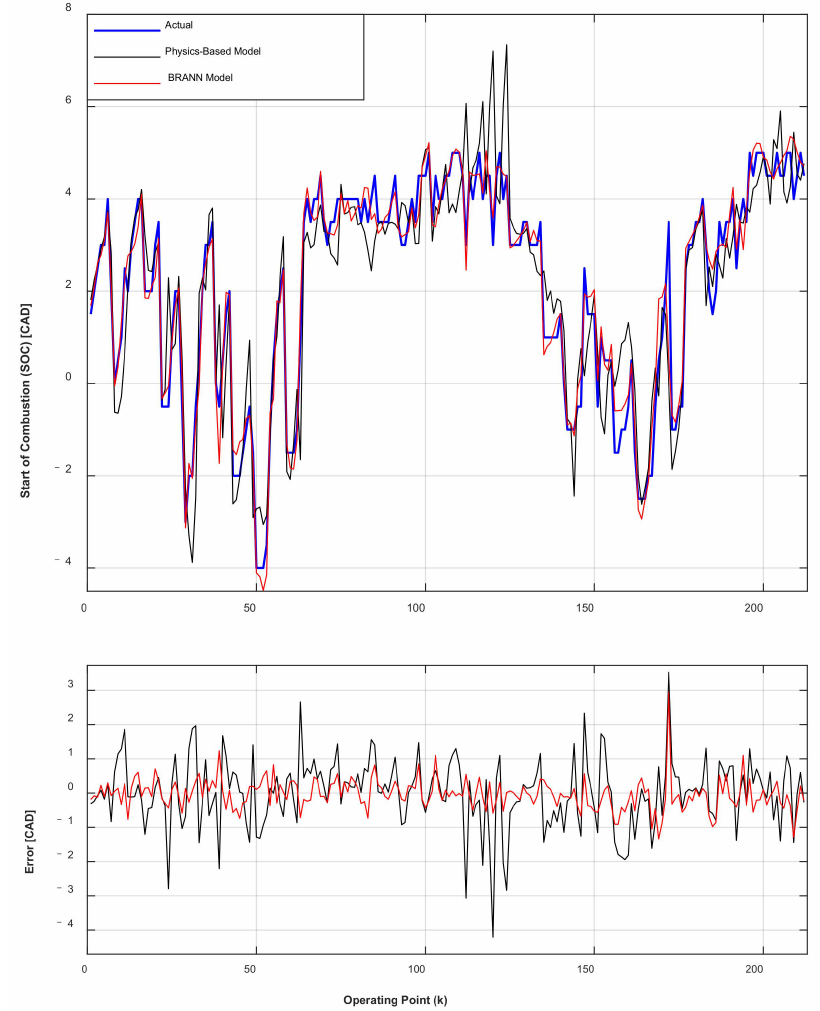
Figure 24. Comparison of the actual SOC, physics-based model prediction, and BRANN